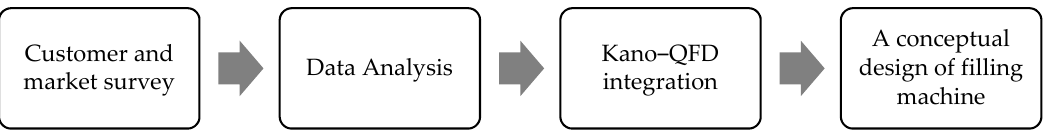
Figure 4. Requirements for accomplishing the proposed approach. QFD: quality function de- ployment.